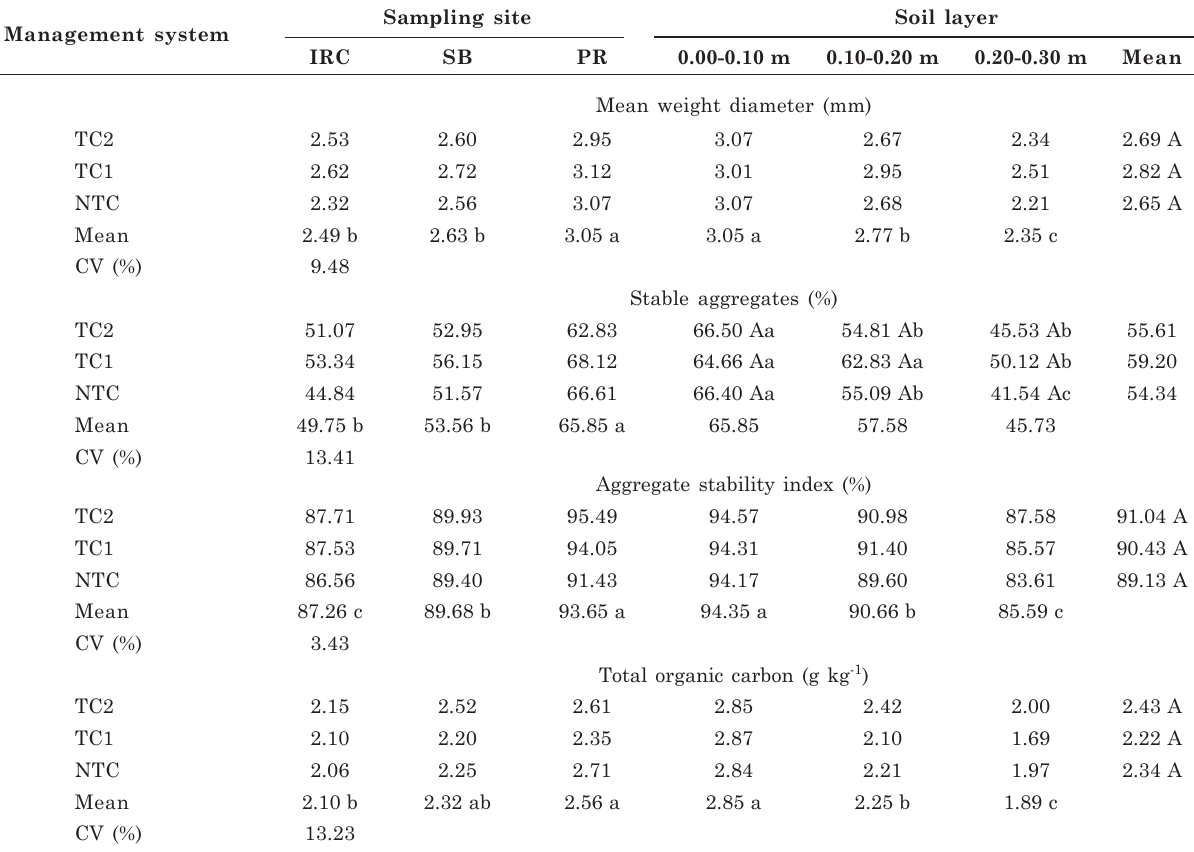
Table 3. Aggregate stability of an Oxisol measured in the plant row (PR), inter-row center (IRC) and seedbed (SB) in the layers in study under managements with traffic control consisting of the adjustment of the track width and use of an autopilot (TC2) and only adjusted track width (TC1) and no traffic